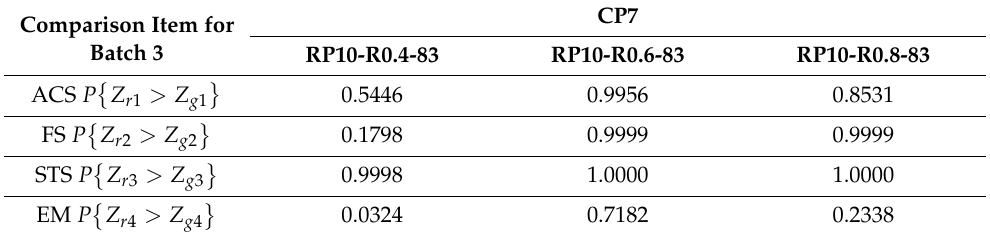
Table 9. Probability that the CVMC for steel fiber concrete is greater that of concrete used for batch 3. Comparison Item for